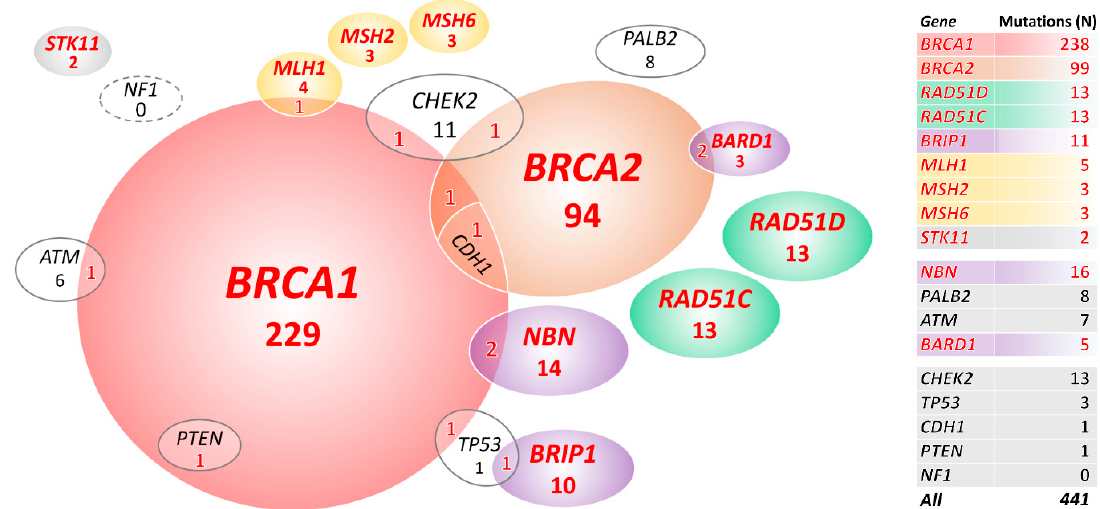
Figure 1. Overall, 427 mutation carriers of 441 mutations in 18 known / anticipated breast cancer (BC)/ovarian cancer (OC) predisposition genes. In total, 399 carriers in genes significantly associated with OC in our study are highlighted in red letters. STK11 is highlighted as rarely mutated but established OC predisposition gene.